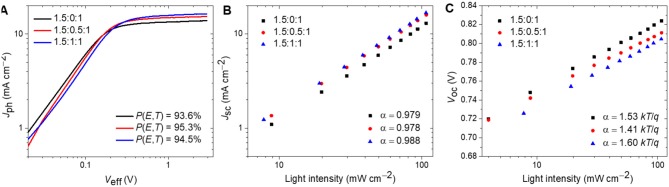
(A)
Jph-Veff curves of the devices; (B)
Jsc-ln(Plight) properties of the devices; (C)
Voc-ln(Plight) properties of the devices.